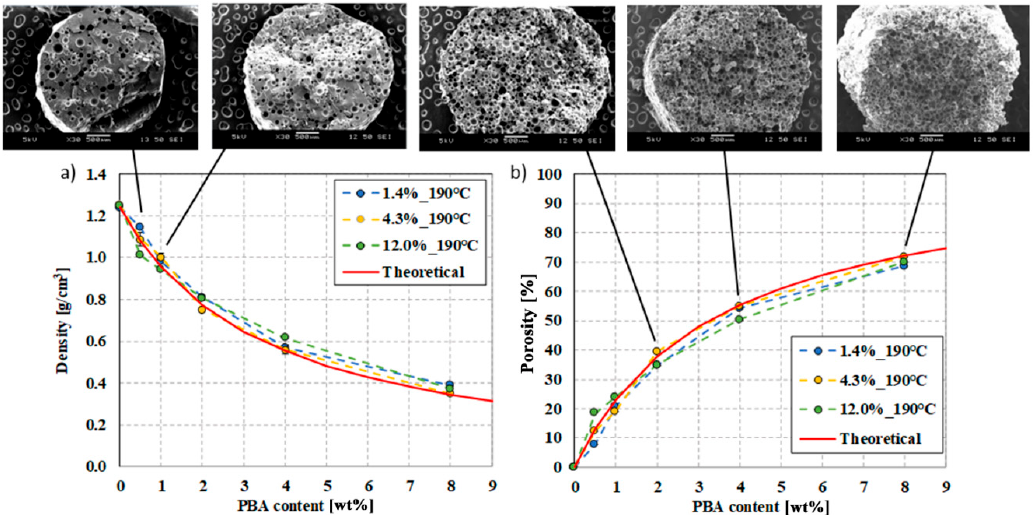
Figure 6. Density ( a ) and porosity ( b ) of samples produced at 190 °C as a function of foaming agent content (theoretically calculated density is shown with a red line).